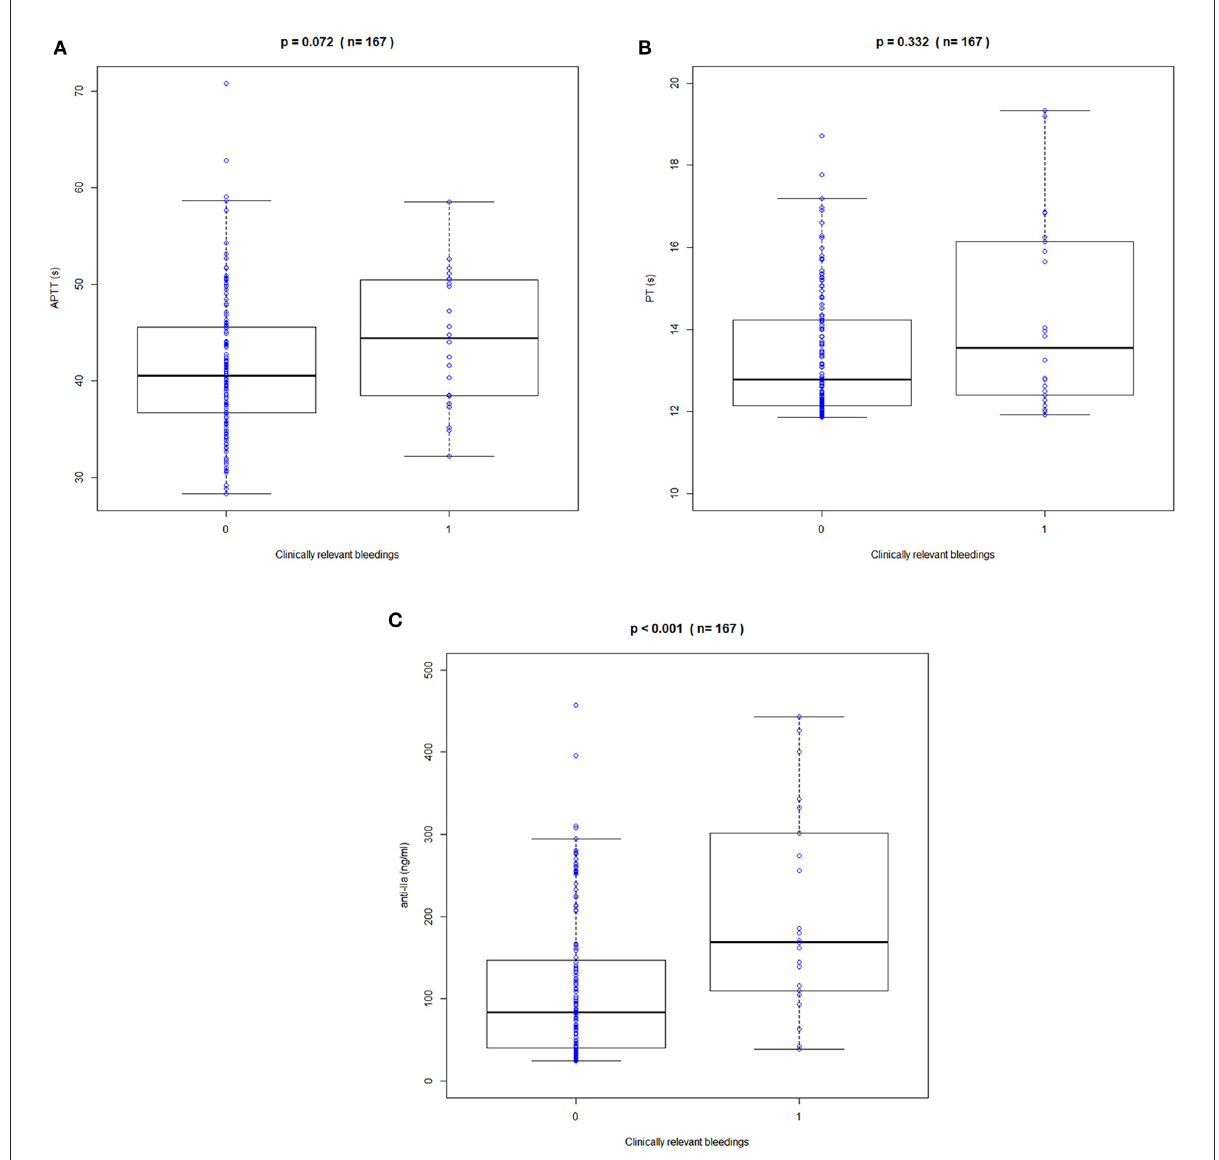
FIGURE3 Correlation between peak APPT, PT, and anti-FIIa values and bleeding events. (A) APTT. (B) PT. (C) Anti-FIIa. Annotation: The blue circle represents the standard dose. Boxes indicate the 25th − 75th percentiles, whiskers represent 1.5 times the interquartile range, and black horizontal lines represent the median. The blue circles are individual predicted values for the standard dose or overdose.